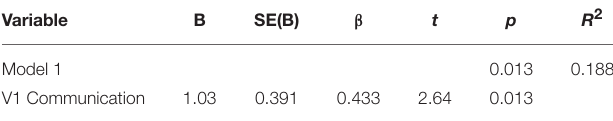
TABLE 8 | Stepwise regression analysis for variables predicting visit 6 object—what question comprehension in TD children ( N =